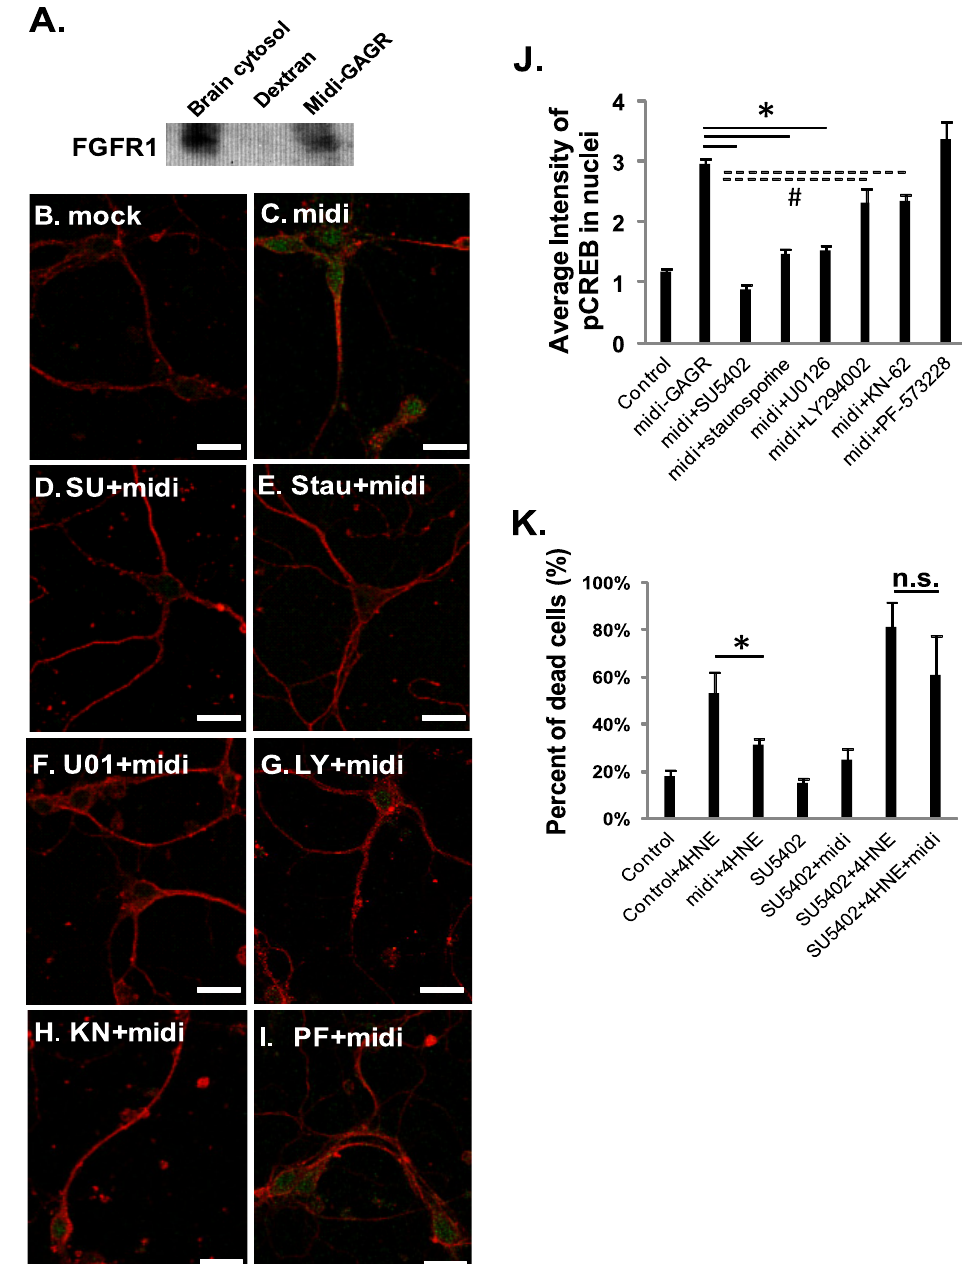
Fig 10. Midi-GAGR binds to FGFR1 and uses FGFR1 signaling pathway to activate CREB and protect neurons from the death caused by oxidative insult. (A) Midi-GAGR- or dextran-conjugated epoxy sepharose beads were mixed with synaptosomal plasma membrane proteins in 0.5% Igepal CA-630 PMEE buffer to pull down midi-GAGR-interacting FGFR1. Precipitated FGFR1 was detected by immunoblotting (n = 2, four rat brains). (B-J) Mouse cortical neurons (DIV4) were pre-treated with H 2 O (vehicle, B,C) or the inhibitors of FGFR1 (SU5402 [SU], 4 μ M, D), PKC (staurosporine [Stau], 3 nM, E), MEK (U0126 [U01], 10 μ M, F), PI3K (LY294002 [LY], 20 μ M, G), CaMKII (KN-62 [KN], 10 μ M, H), or PF-573228 (PF, 1 μ M, I) for 6 h and then with mock (B) or 1 μ M midi-GAGR (+midi, C-I) for 48 h. Neurons were then immunostained with the antibodies to α -tubulin (red) and p-CREB (green). Scale bar = 100 μ m. (J) Bar graphs show the average intensities of pCREB after different treatments (n = 60 neurons, mean ± SEM). * , p < 0.01 and #, p < 0.05 compared to control. (K) Rat cortical neurons (E17, DIV6) were treated for 6 h with FGFR1 inhibitor (SU5402, 4 μ M) and treated with 10 μ M 4HNE and either vehicle or 1 μ M midi-GAGR for 24 h prior to cell